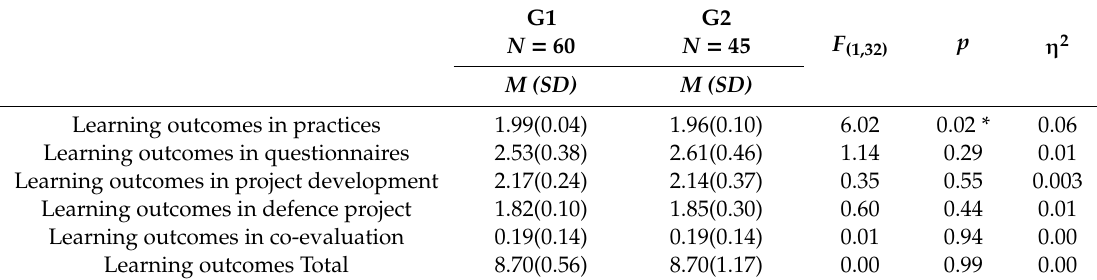
Table 3. Single factor fixed-e ff ects ANOVA (IPA use vs.